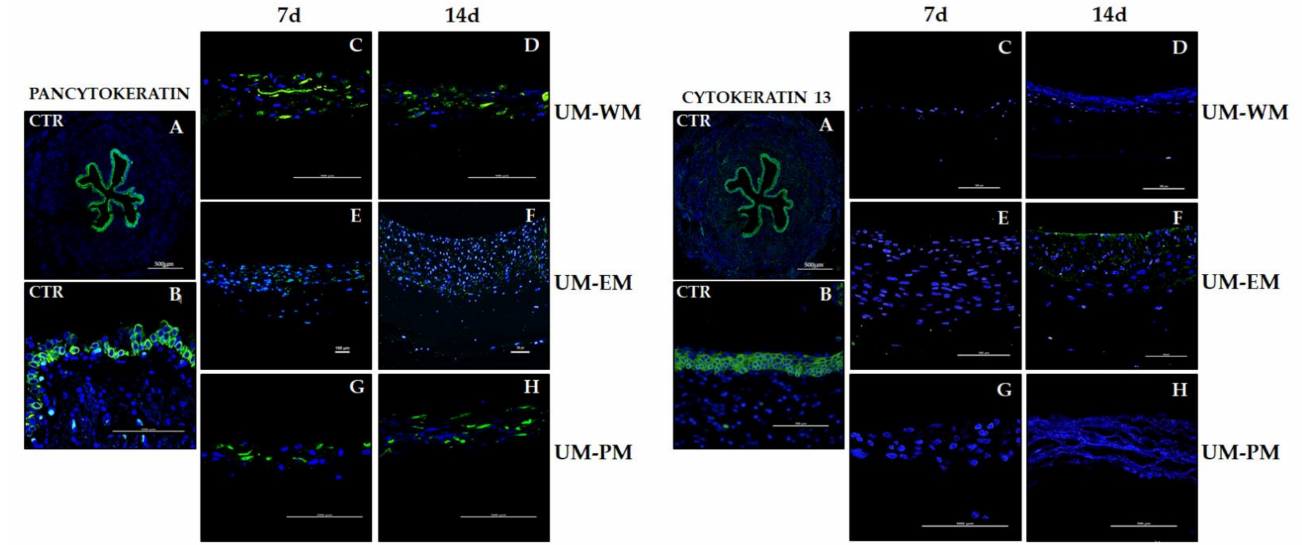
Figure 5. Immunofluorescence analysis of pancytokeratin and cytokeratin 13 in control human UM (CTR) and tubularized heterotypical substitutes of the human UM cultured with three different media (WM, EM, and PM) for 7 and 14 days. Scale bars: 500 µ m in ( A ) and 100 µ m in ( B – H ) panels. Table 2. Semiquantitative analysis of relevant epithelial markers in control native UM (CTR) and in the stromal substitute of heterotypical substitutes of the human UM cultured in WM, EM, and PM media for 7 and 14 days as determined by immunofluorescence. Results were assessed as strong positive signal (+++), positive signal (++), mild signal (+), or negative ( − ).